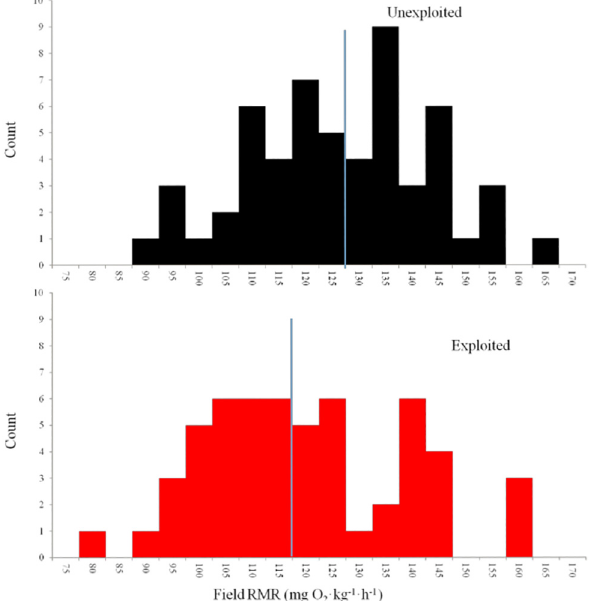
Fig 1. Distribution of Field Resting Metabolic Rates. Histogram of field resting metabolic rates of unexploited populations (black bars) and exploited populations (red bars) of Largemouth Bass raised in a common environment. X-axis values represent the starting value of each bin. Vertical reference line represents the median of each